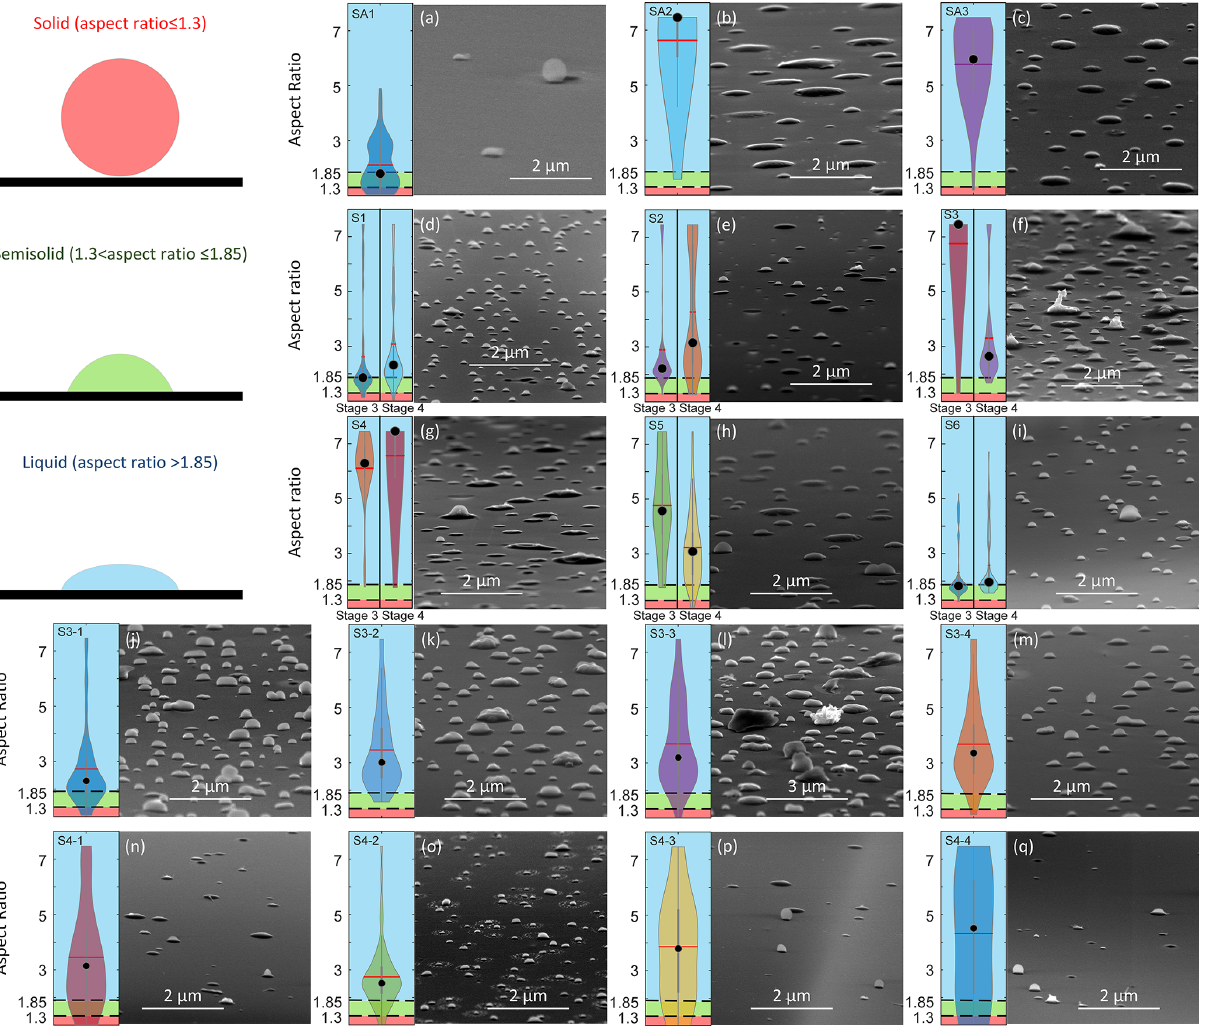
Figure 5. Violin plots of the corrected aspect ratio (left) and typical tilted images (right) for Pico 2014 (a–c) , Pico 2015 (d–i) , and Pico 2017 (j–q ). The distributions in the two panels to the left of the image in each of (d–i) are the aspect ratios of Pico 2015 particles collected on stages 3 (left) and 4 (right). The shaded regions correspond to the different phase states (red: solid state; green: semisolid state; blue: liquid state). The red lines indicate the means and the black dots the